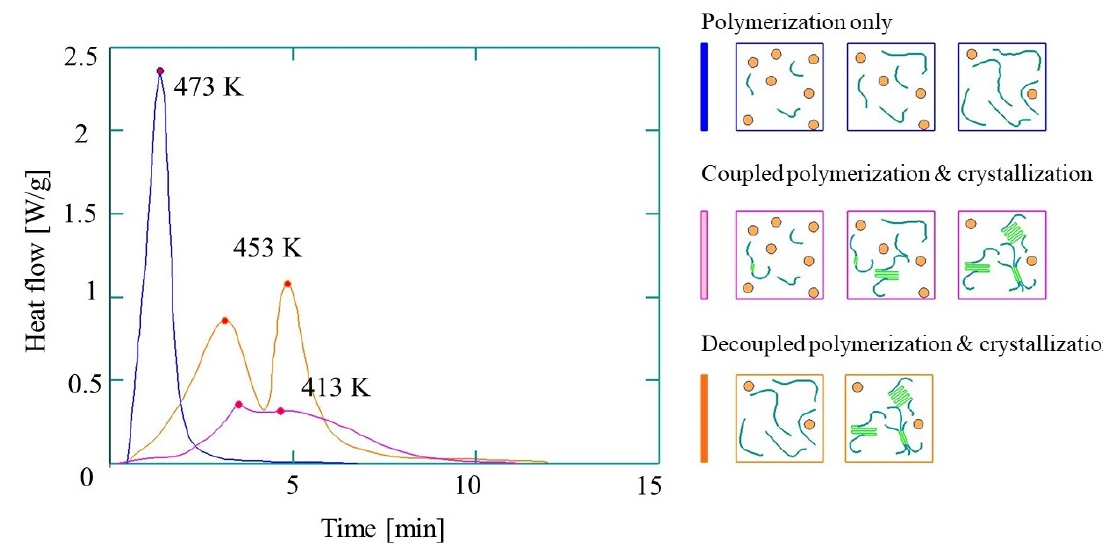
Figure 5. Di ff erential Scanning Calorimetry (DSC) curves of the synthesis of reactive PA-6 (based on Figure 5. Differential Scanning Calorimetry (DSC) curves of the synthesis of reactive PA ‐ 6 (based on reference [58], reproduced with copyright permission from Elsevier, reference [58], reproduced with copyright permission from Elsevier, 2017).